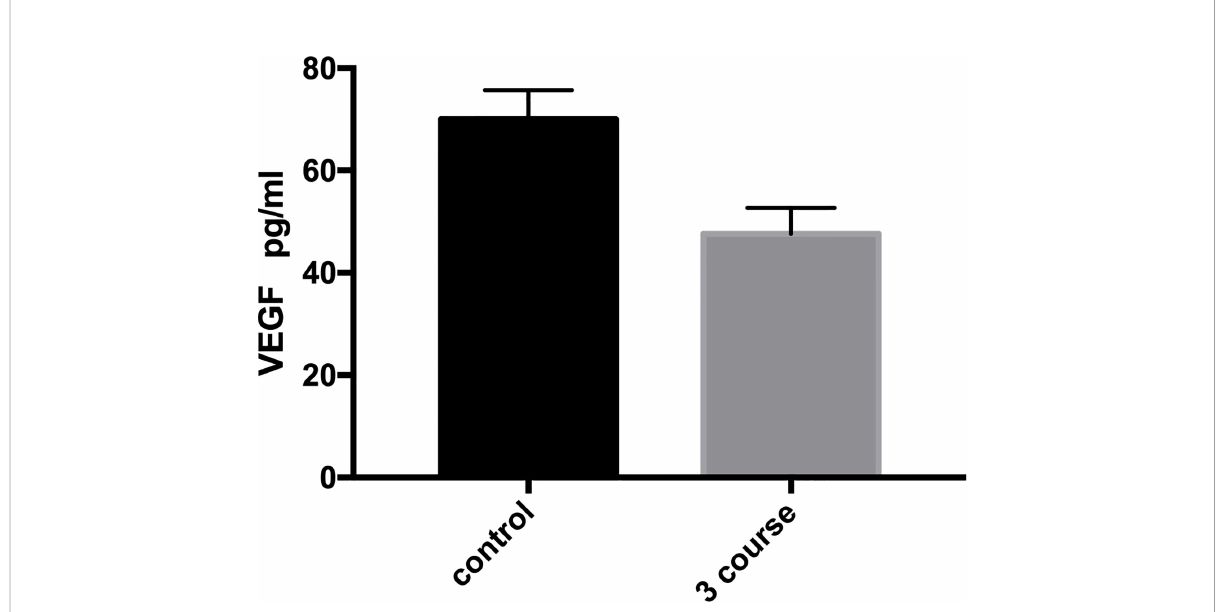
FIGURE 2 Relationship between VEGF and the course of injection in infantile hemangioma (IH). VEGF decreased signi fi cantly after 3 courses of treatment. P=0.0043.